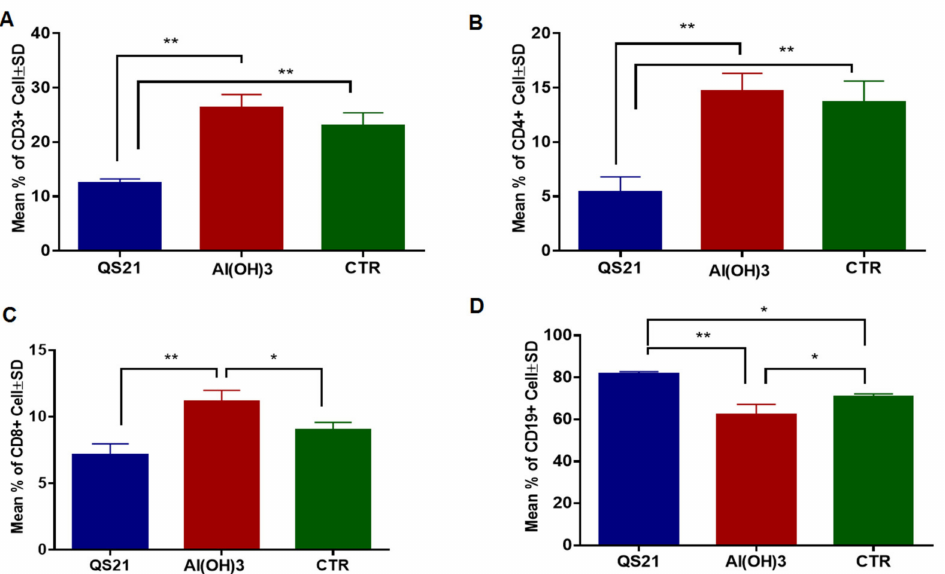
Figure 5. B and T cell population detection post vaccination. ( A ) CD3+ cell population; ( B ) CD4+ cell population; ( C ) CD8+ cell population; ( D ) CD19+ cell population. (* p < 0.05, ** p < 0.01, N = 3 per